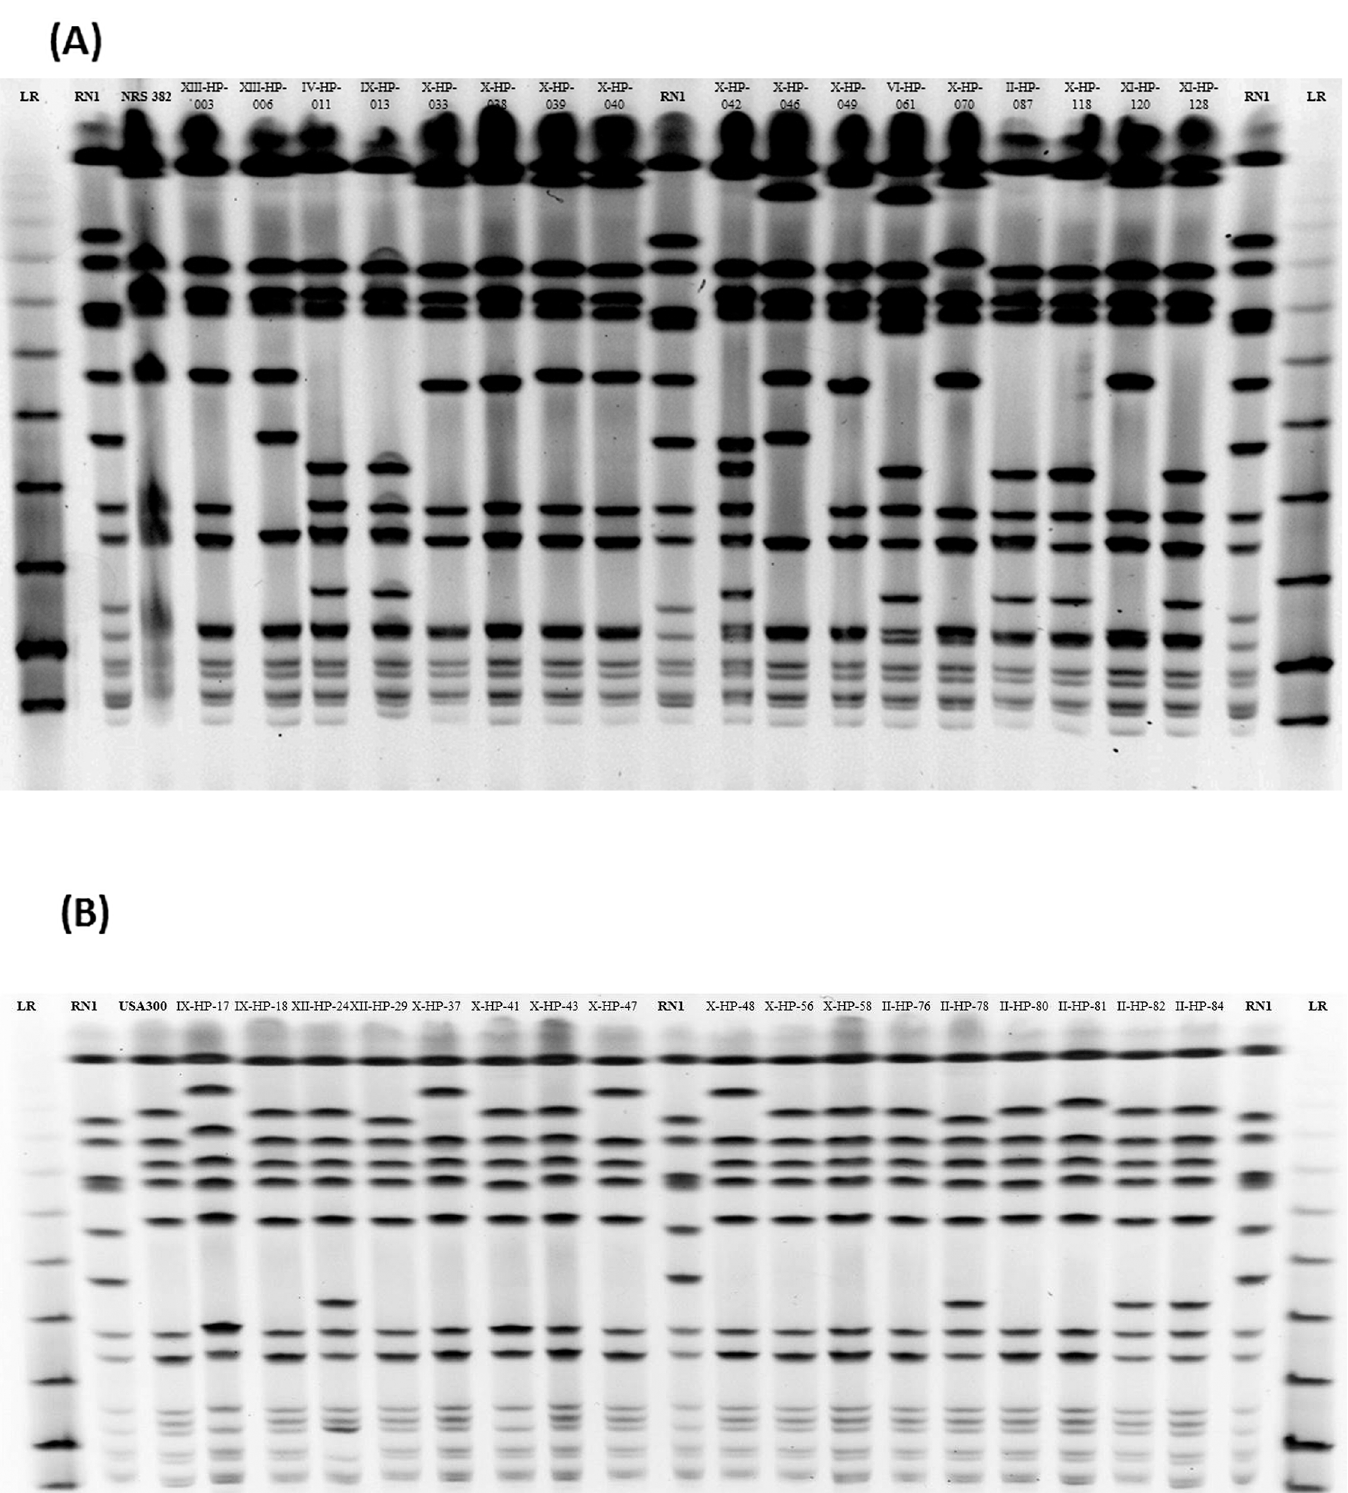
Fig 3. PFGE profiles of hospital isolates representing the major clonal types of MRSA identified in the 1996 (A) and the 2013/14 study (B). (A) PFGE of USA100 isolates in 1996 [2] . (B) PFGE of USA300 isolates in 2013/14. Migration on TBE-agarose gel after digestion with SmaI restriction enzyme.